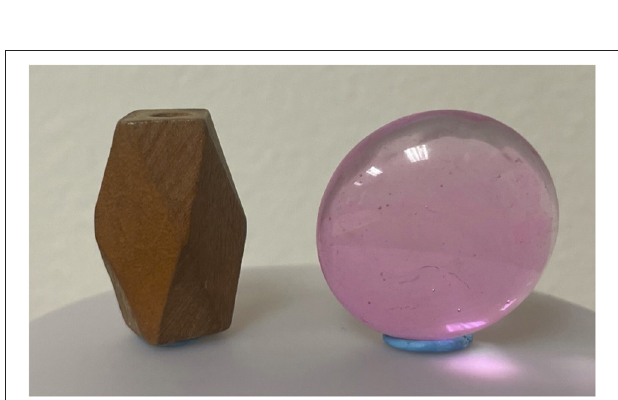
FIGURE 2 | The two objects used in the NOR test; a simple spherical pink bead and a simple rod-shaped brown